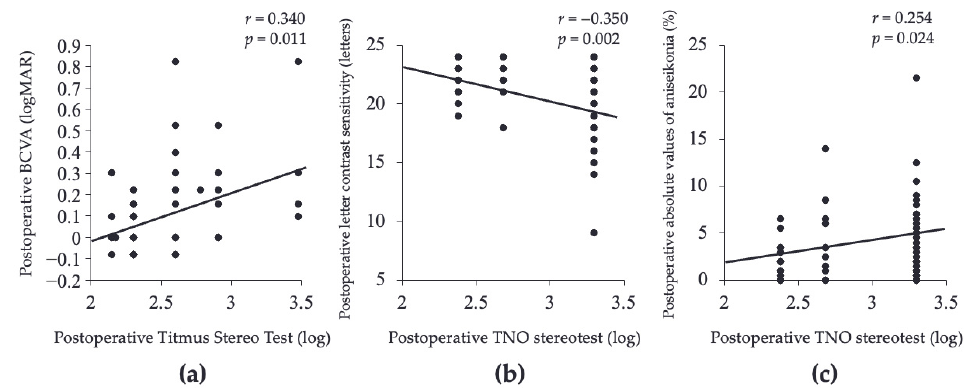
Figure 2. Association between stereopsis and visual function factors in patients with impaired stereopsis after retinal detachment surgery. The TST was associated with postoperative BCVA ( a ), and the TNO was associated with letter contrast sensitivity ( b ) and absolute values of aniseikonia ( c ).